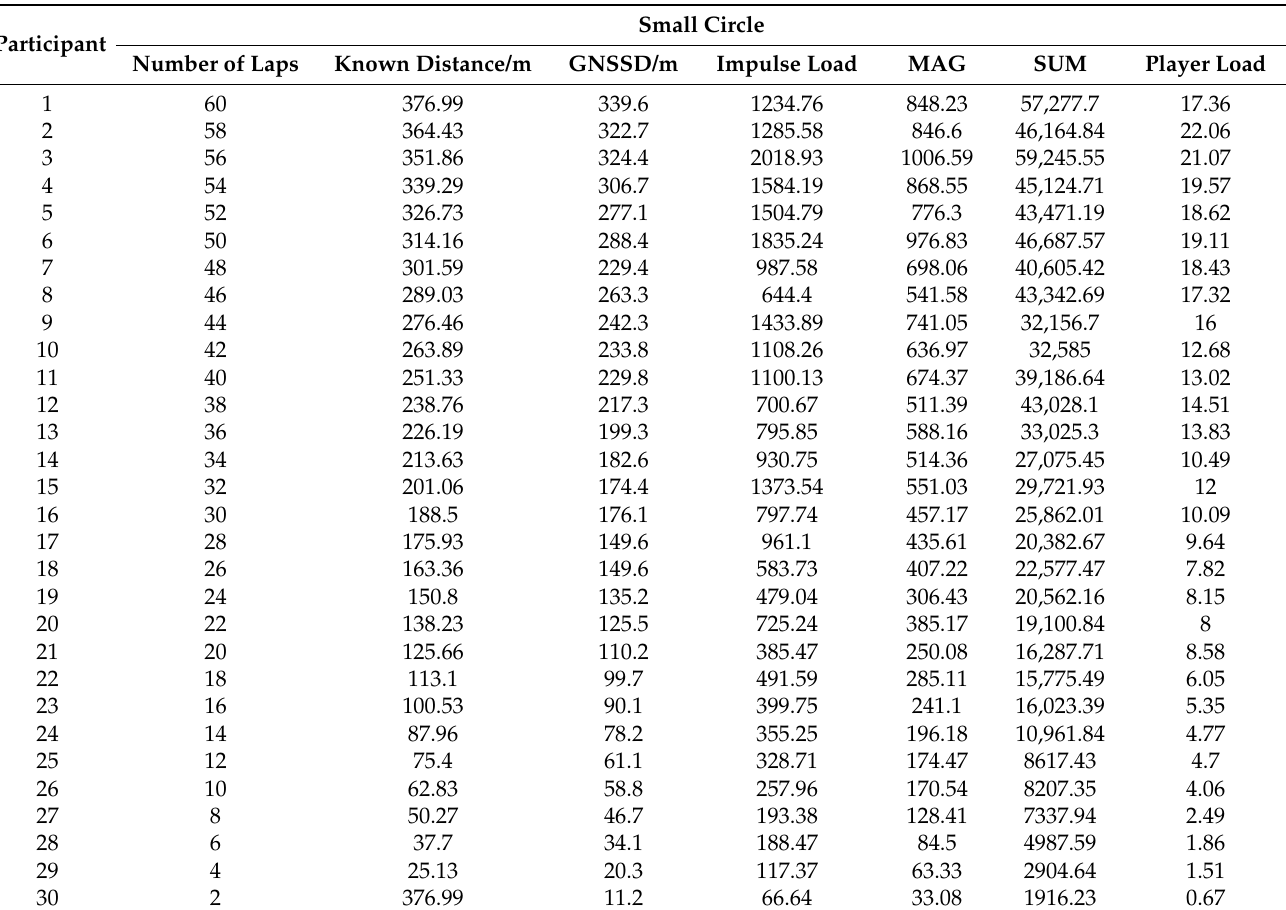
Table 5. Details for each trial include laps and known distance completed around the small circle course, GNSS measured distance, and all accelerometry derived metrics.